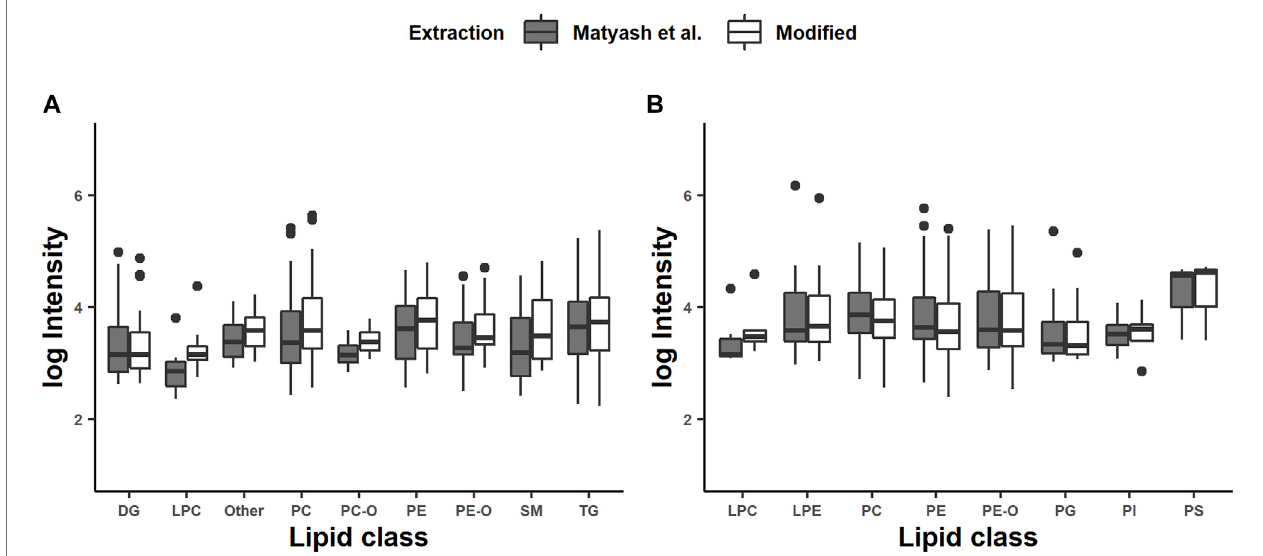
FIGURE 1 | Intensities of chosen lipid classes generated in positive (A) and negative (B) modes: diglyceride (DG), lysophosphatidylethanolamine (LPE), phosphatidylcholine (PC), phosphatidylethanolamine (PE), phosphatidylinositol (PI), phosphatidylglycerol (PG), phosphatidylserine (PS), sphingomyelin (SM), triacylglyceride (TAG), and other lipid classes. The intensities of identi fi ed lipids are represented as averages from triplicate determination.